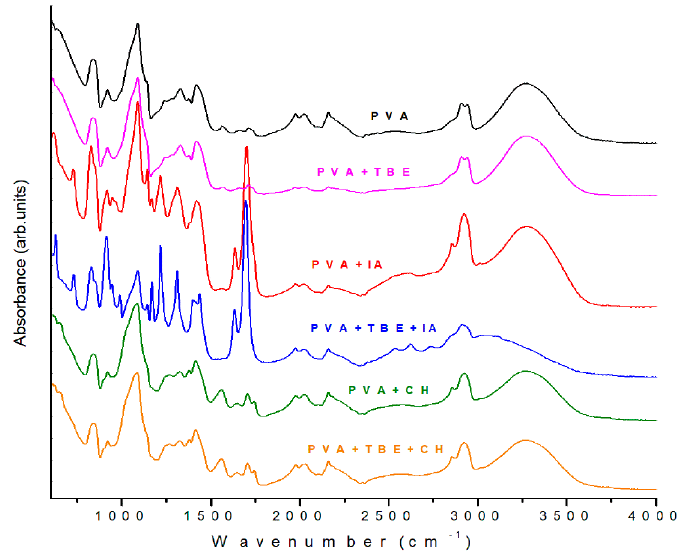
Figure 6. FTIR spectra of the solid films.